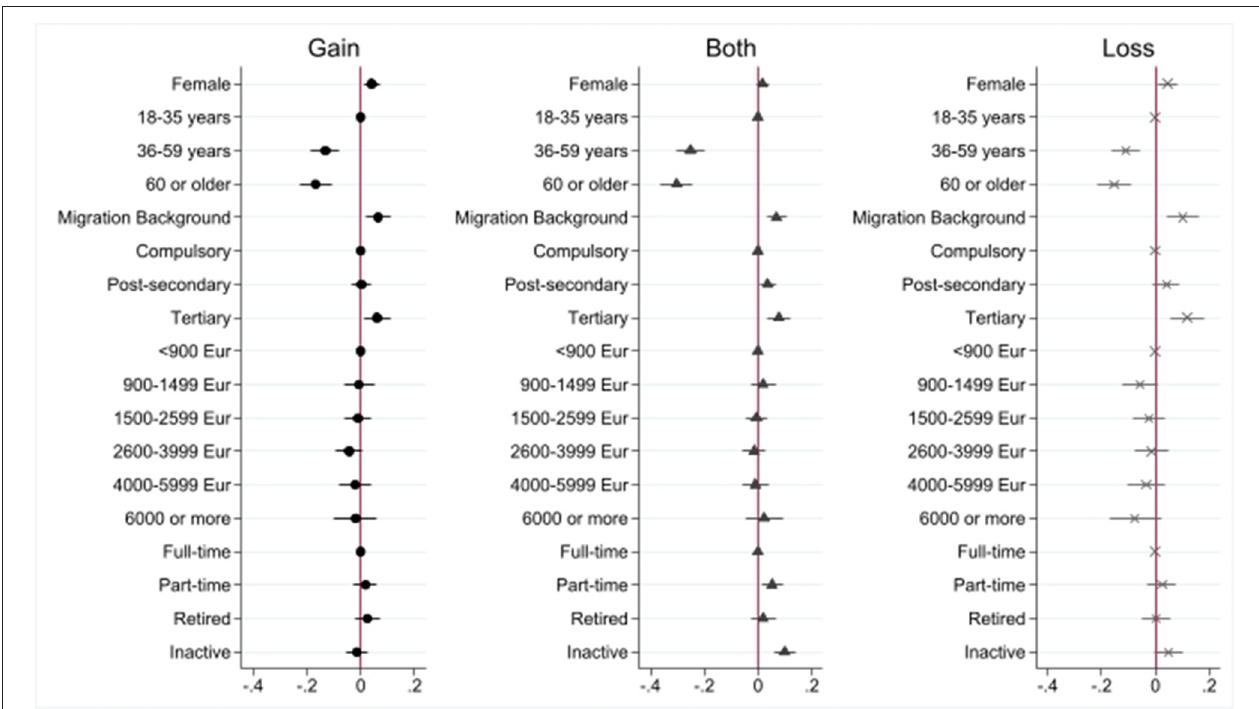
FIGURE 3 | Co-occurring Changes. Source: Survey “Living in exceptional circumstances” Wave 3 (spring 2021). n = 3,713 respondents, 18–98 years. Multivariate logistic regression models, weighted, Average Marginal Effects (difference in likelihood in percent). Gain resp. loss of friends and acquaintances jointly modeled (1 = gain/loss of either). For coefficients, see Supplementary Table 3